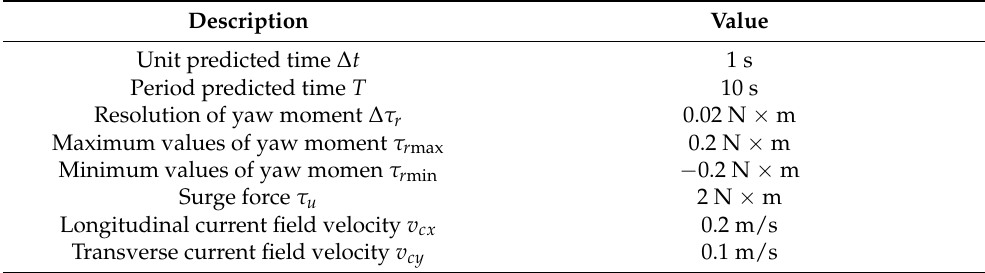
Table 1. Simulation parameters of